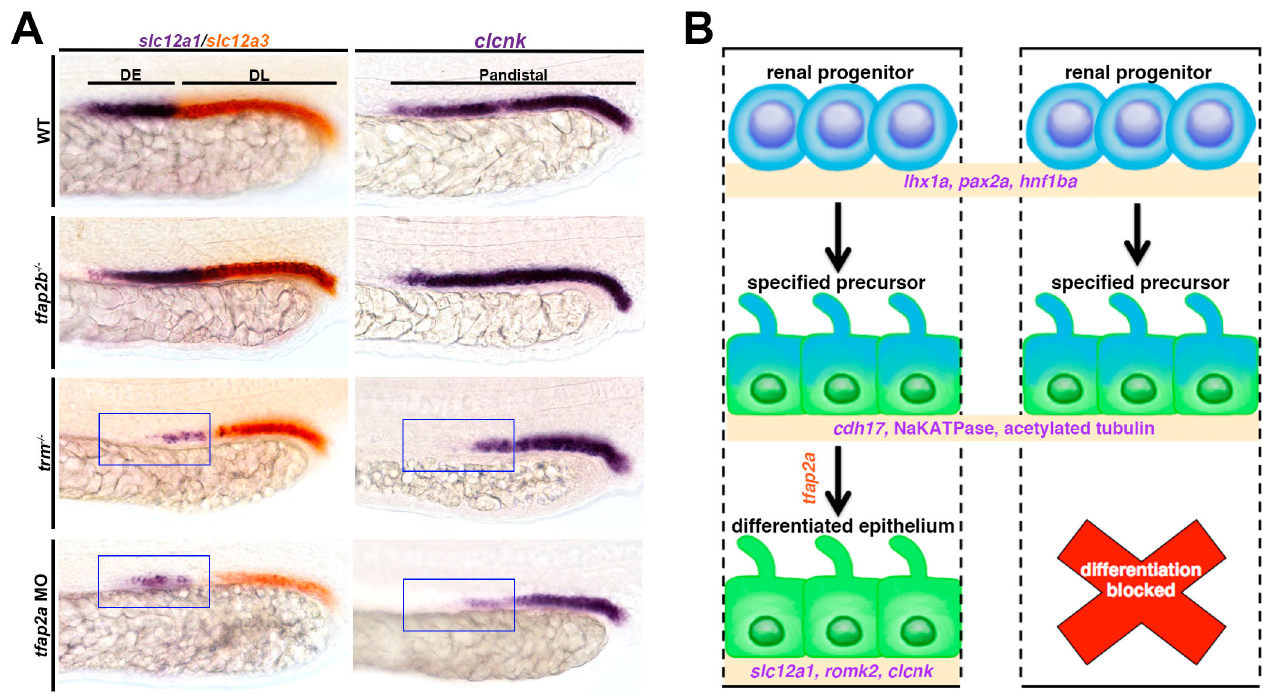
Figure 4. Role of Tfap2 transcription factors in DE segment differentiation in the zebrafish pronephros. ( A ) trm mutants exhibit reductions (indicated by blue boxes) in the expression of transcripts that encode DE segment solute transporters, such as slc12a1 . ( B ) Tfap2a is a requisite for discrete aspects of DE differentiation, but is not required for features such as polarity establishment and ciliogenesis. Adapted from Ref. [148].